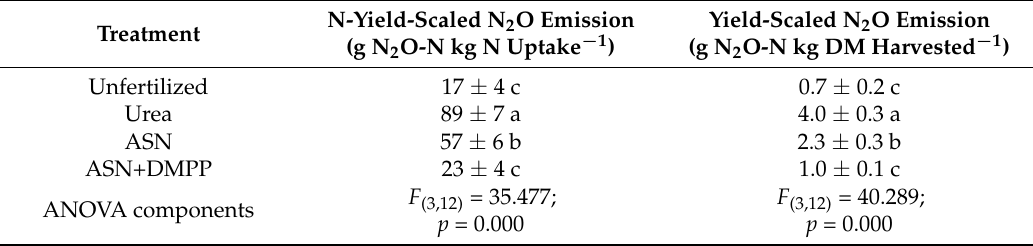
Table 4. N-yield-scaled N 2 O emissions and yield-scaled N 2 O emissions. Values in cells with different letters are significantly different ( p < 0.05; n =